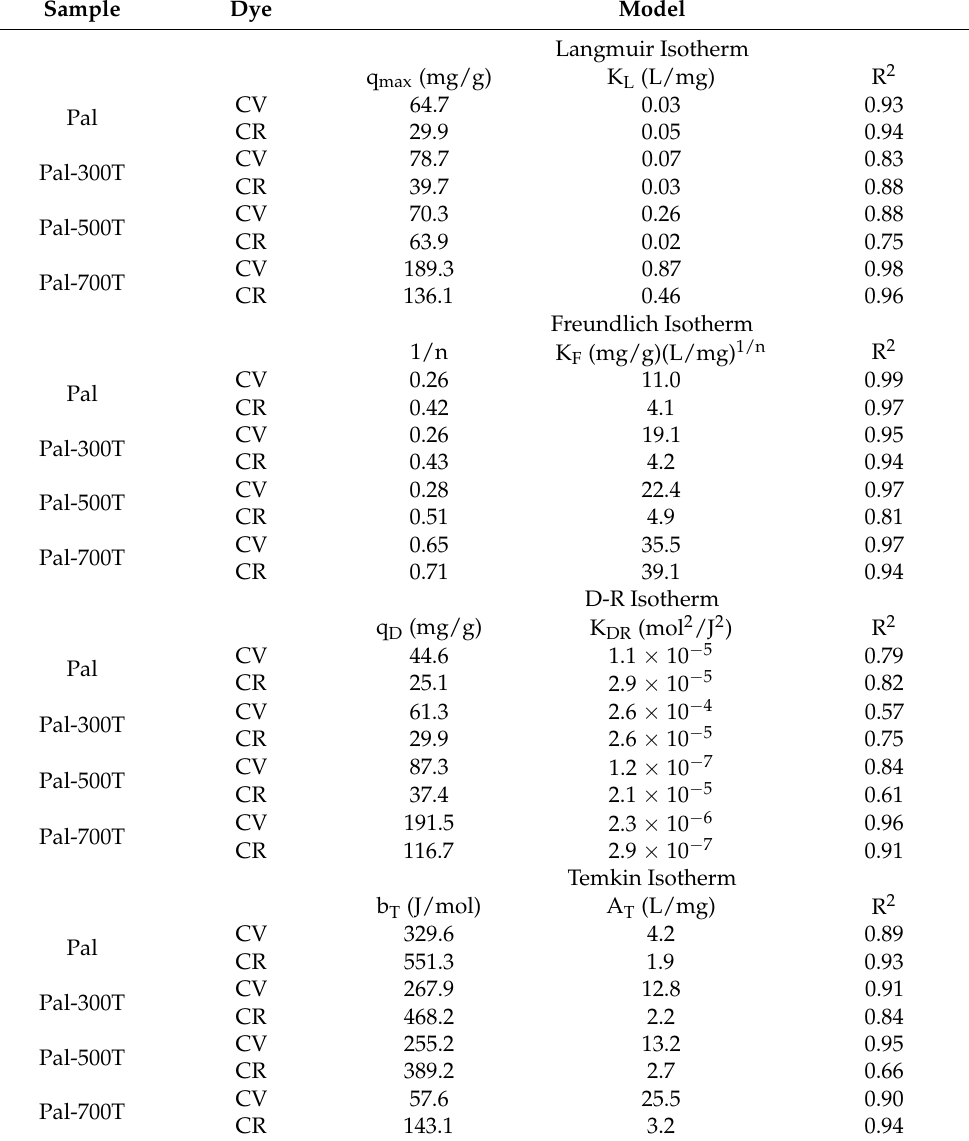
Table 3. Langmuir, Freundlich, D-R and Temkin isothermal parameters for CV and CR